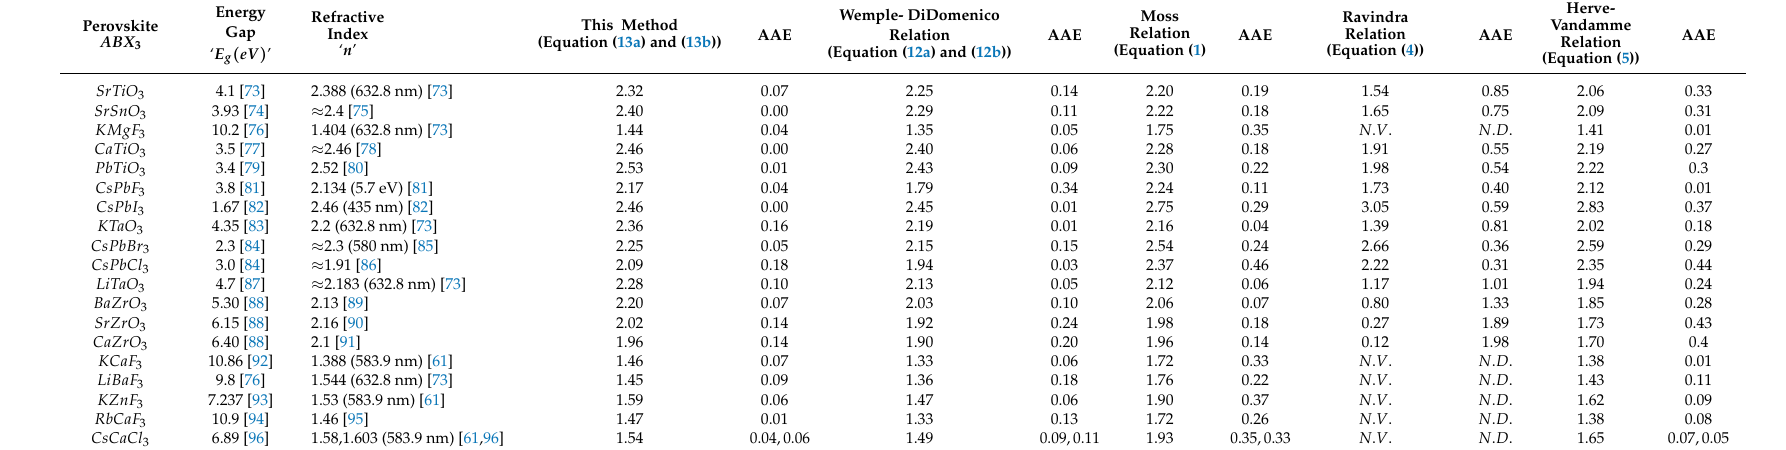
Table 1. Comparison of refractive indices computed by various models with the literature values. AAE, absolute accuracy error. Perovskite ABX